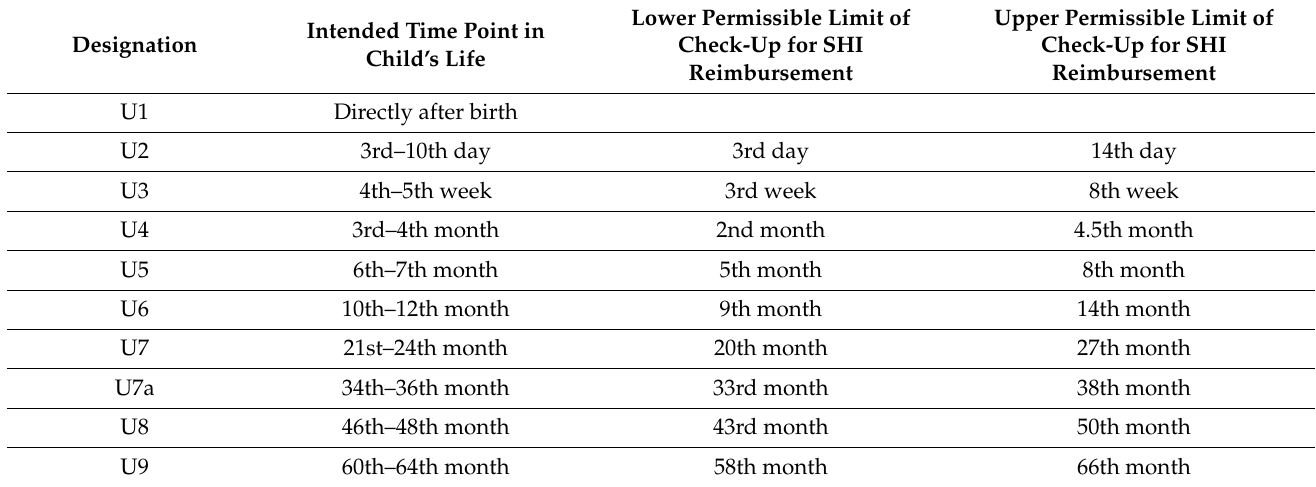
Table 1. Summary of paediatric check-ups to be conducted in the first six years of a child’s life [12].